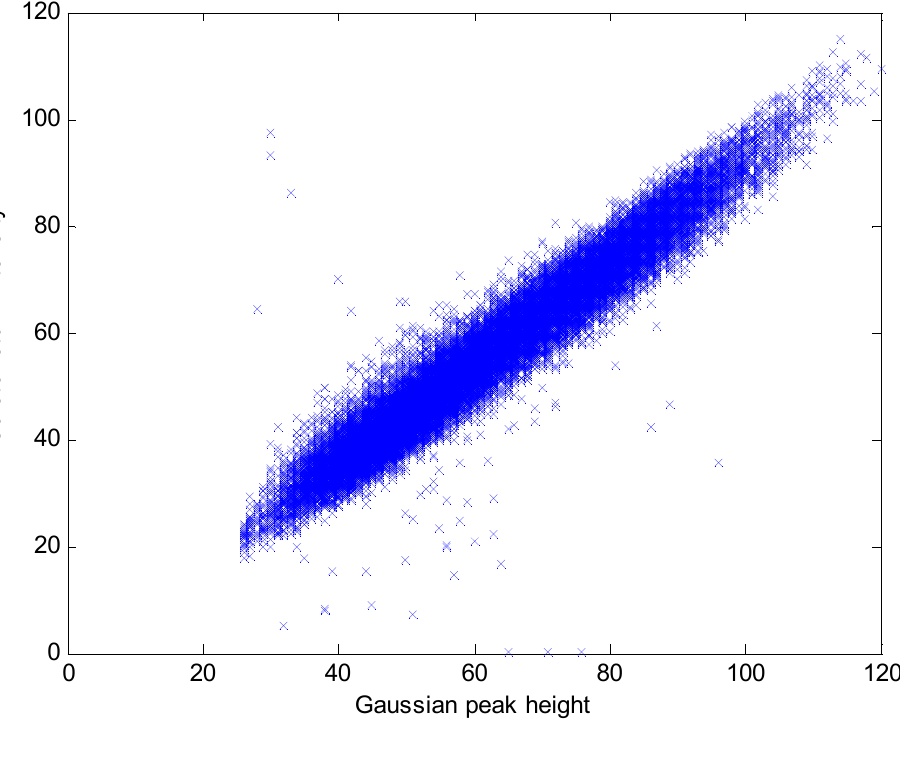
Figure 5. Peak height of Gaussian curves fitted to deconvolved waveform LiDAR vs . corresponding discrete return intensities recorded by the discrete-return LiDAR